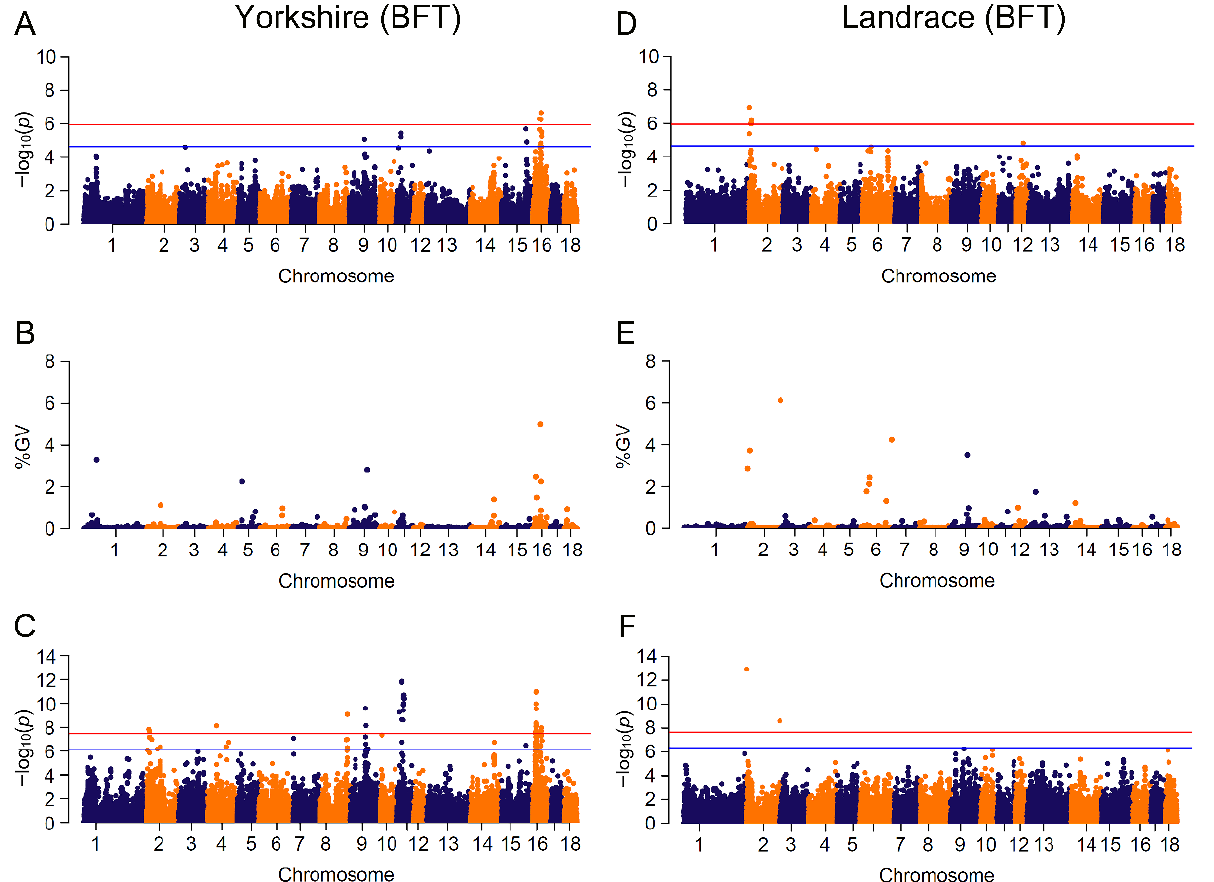
Figure 3. Manhattan plots for BFT (backfat thickness) by breed in different GWAS approaches. The red and blue lines in plots represent genome-wide and suggestive significance thresholds, respec- tively. Results in Yorkshire population for: ( A ) CL_GWAS; ( B ) CB_GWAS; ( C ) IL_GWAS. Results in Landrace population for: ( D ) CL_GWAS; ( E ) CB_GWAS; ( F ) IL_GWAS. %GV denotes the pro- portion of genomic variance explained by the region identified. Table 2. Summary of genomic regions significantly associated with growth-related traits of three statistical analyses.